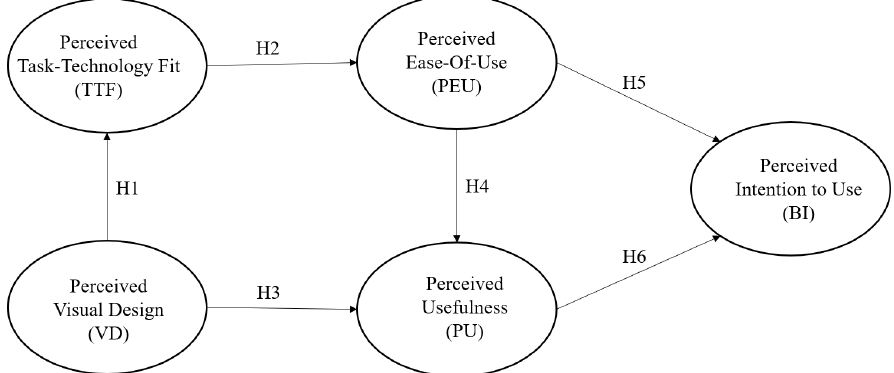
Figure 8. The conceptual research model adapted from [31] with extensions of task–technology fit and visual design variables. Each set of ellipses represents a construct and an arrow denotes a